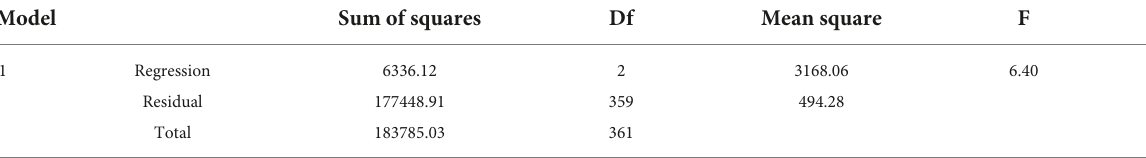
TABLE 4 ANOVA for Chinese EFL teachers’ aggression, burnout, and success. Model